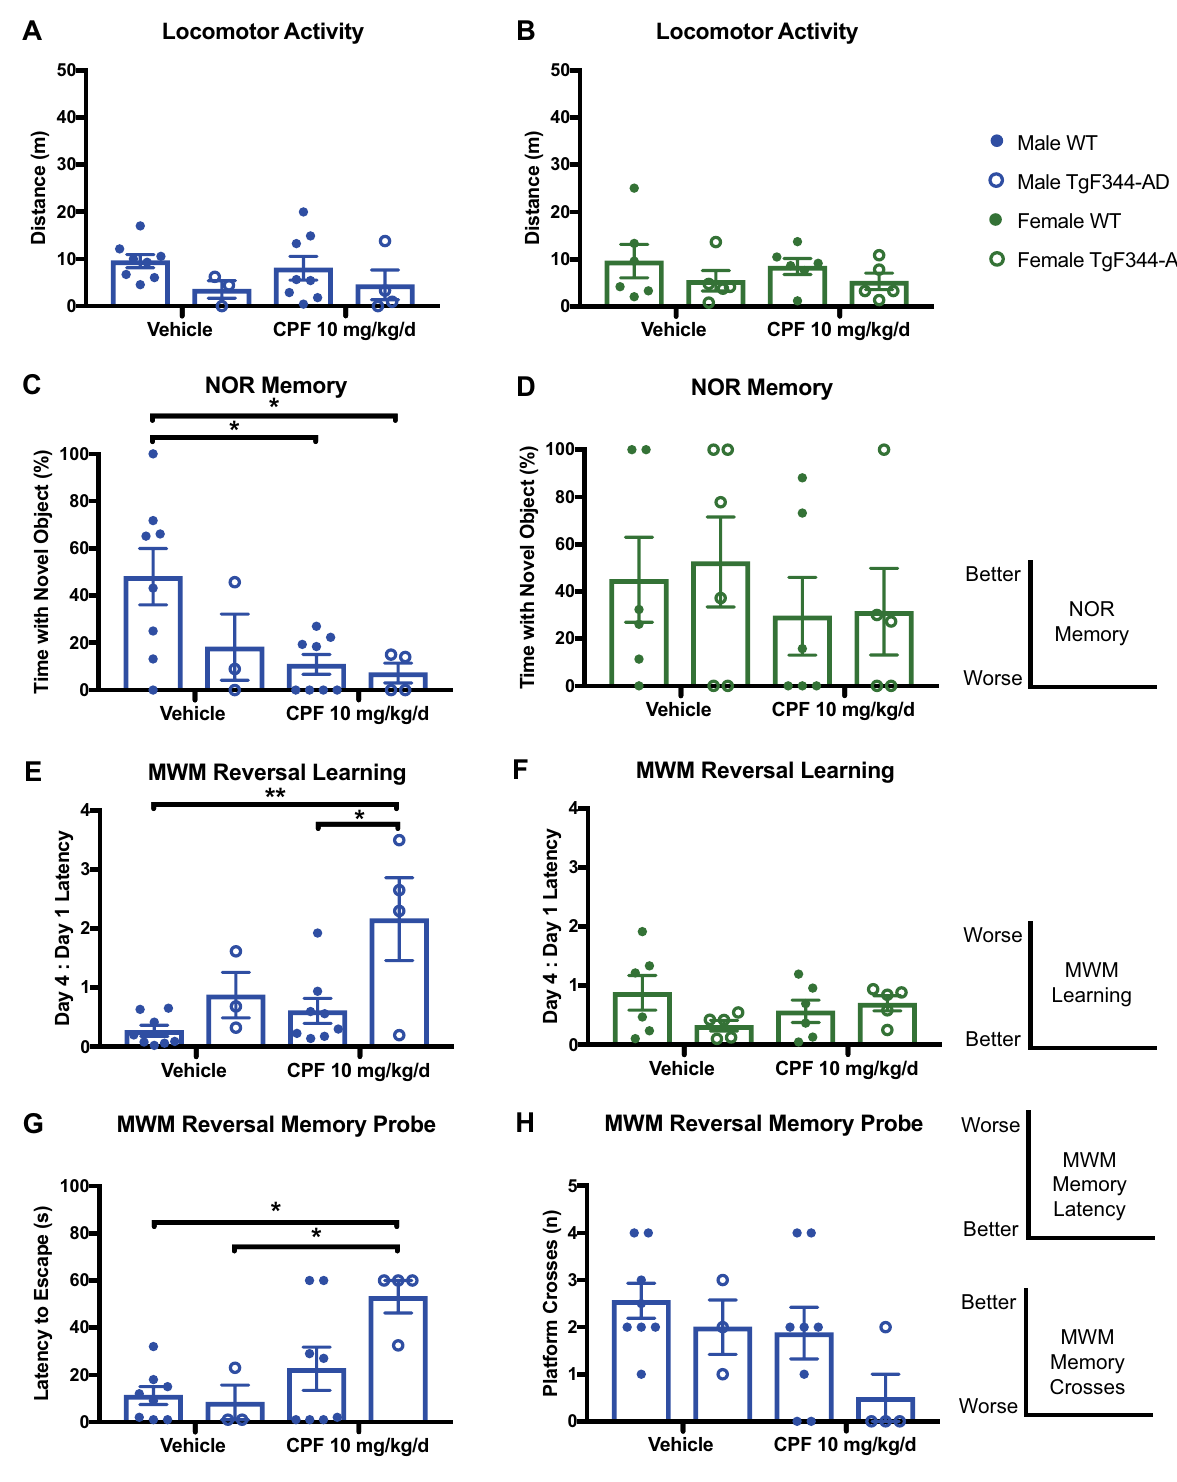
sex, genotype, or exposure, was roughly 50%. At this age, ~95% of Fischer rats develop neoplasms that impede mobility or reduce quality of life. 36 Because repeated surgical mass removal was prohibited by animal care staff, rats were euthanized if they required more than one mass removal. Although the reduced number of animals at the fi nal time point resulted in greater variability, it was clear in the MWM reversal learning phase and memory probe that early-life occupational-like CPF